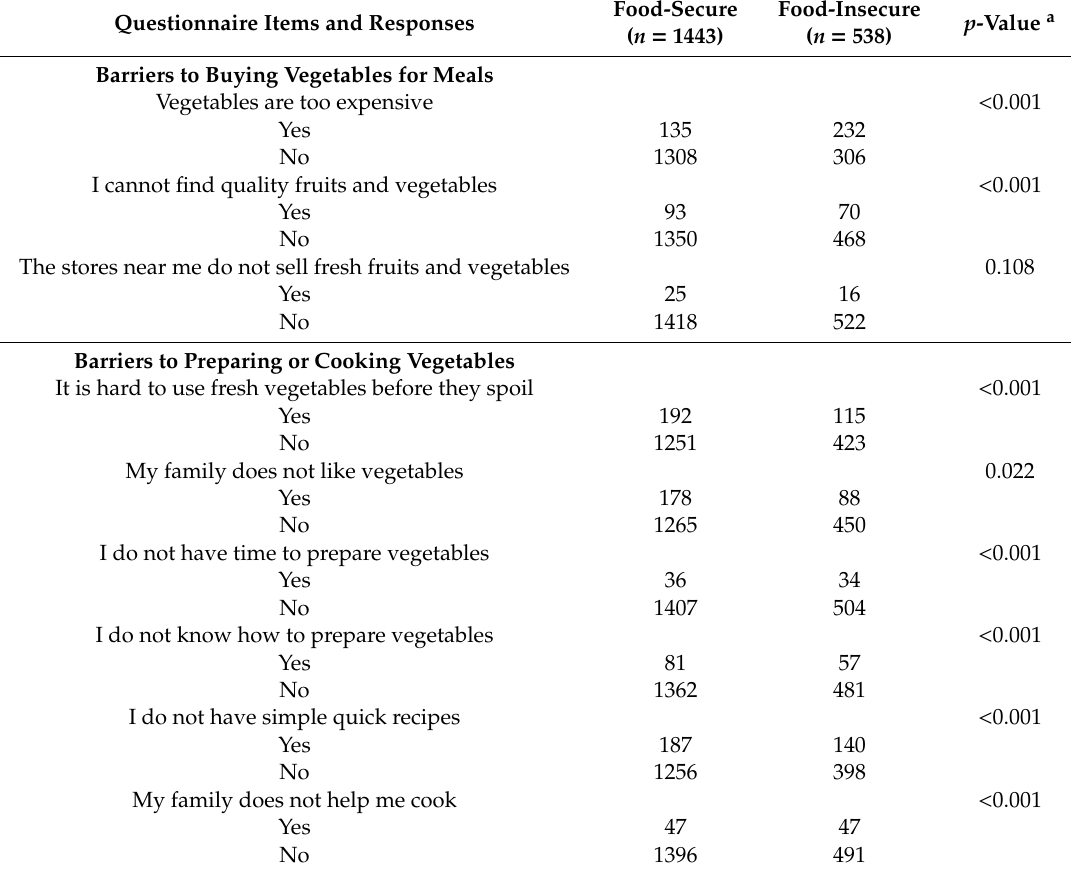
Table 2. Distribution of reported barriers to buying and preparing / cooking vegetables between food-secure and food-insecure